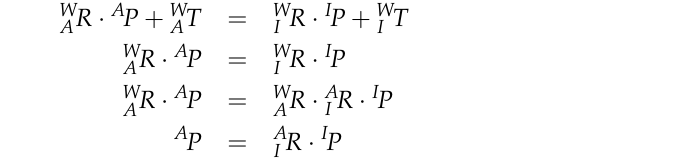
Figure 13. Components for deriving A coordinate frame F A and F I , respectively, we can derive the rotation A F I into F A